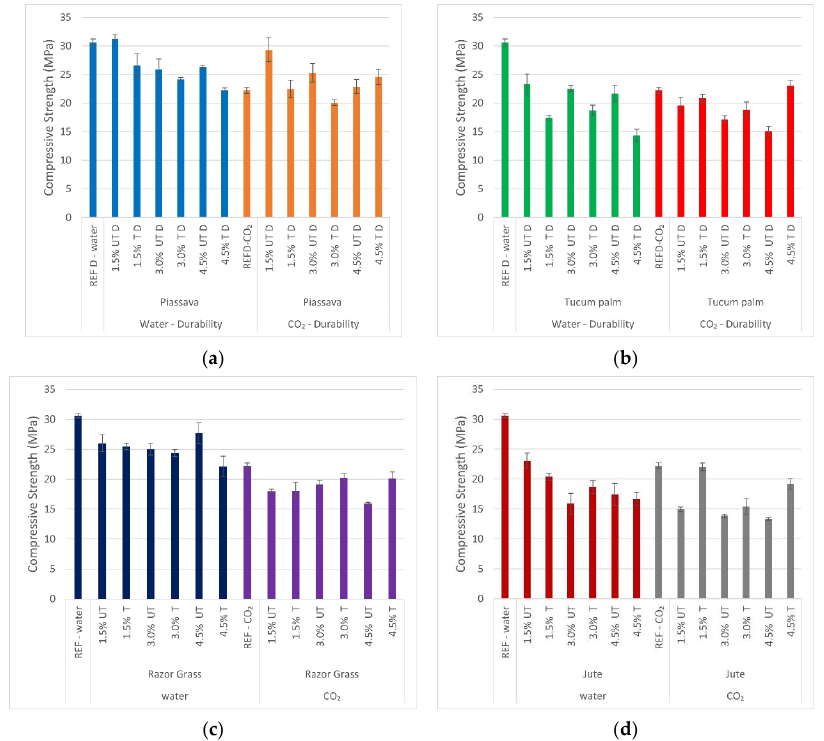
Figure 11. Durability cycles — compressive strength mortars: ( a ) 1.5%; 3.0%; 4.5% piassava mortars; ( b ) 1.5%; 3.0%; 4.5% tucum palm mortars; ( c ) 1.5%; 3.0%; 4.5% razor grass mortars; ( d ) 1.5%; 3.0%; 4.5% razor grass mortars; REFD — specimen without fiber after durability cycles; UTD — untreated fiber mortar after durability cycles; TD — treated fiber mortar after durability cycles; water and CO 2 — cured